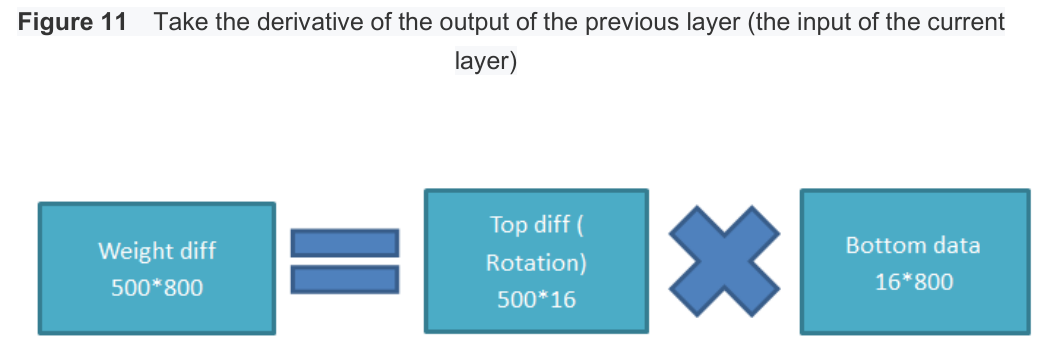
Differentiate the weight coefficient